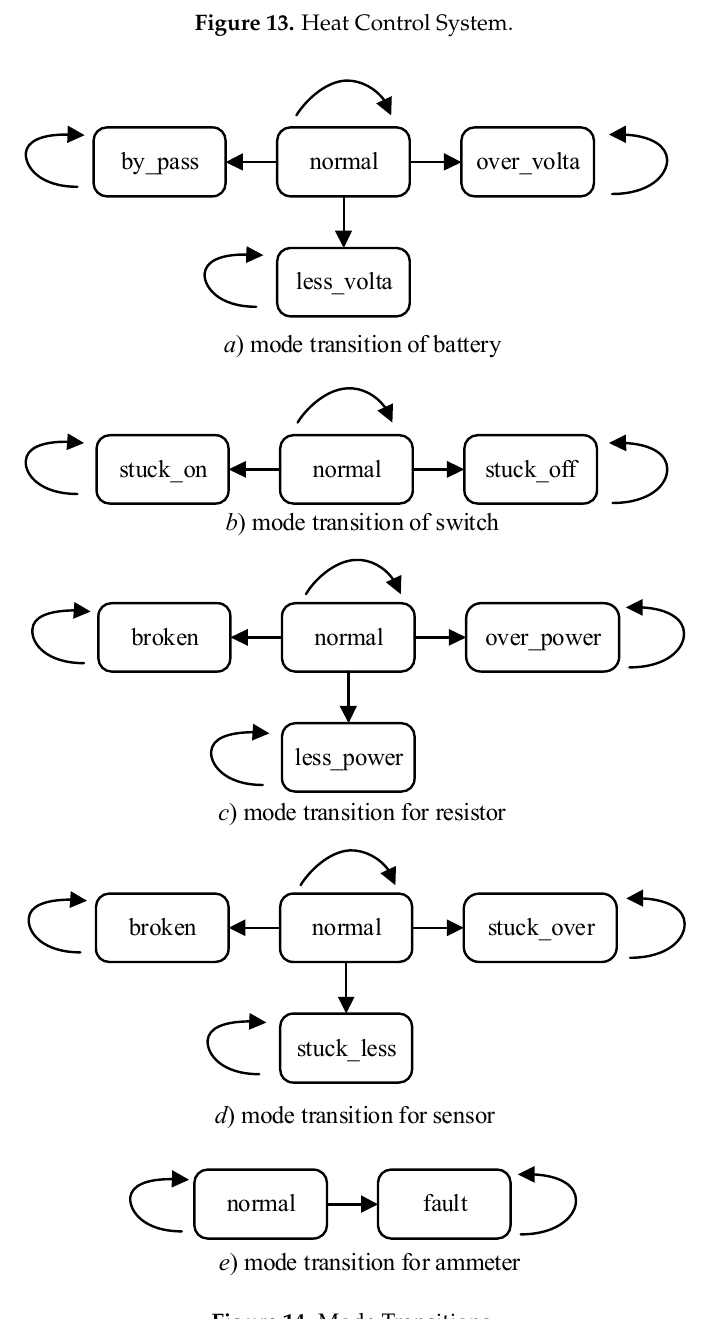
Figure 14. Mode Figure 14. Mode Transitions. Figure 14. Mode Transitions.